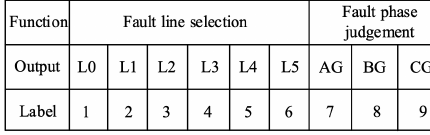
Fig. 7. Fault classification label